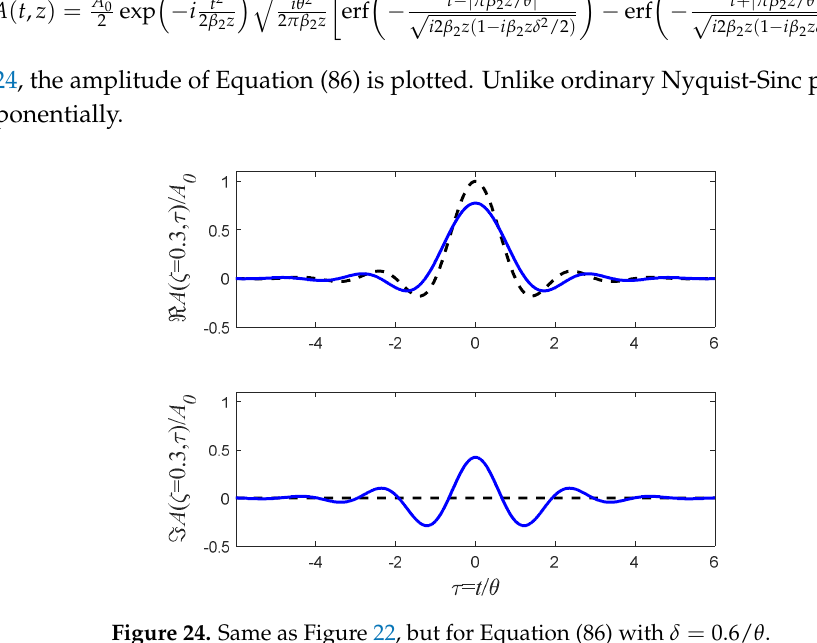
Figure 24. Same as Figure 22, but for Equation (86) with δ = 0.6/ θ